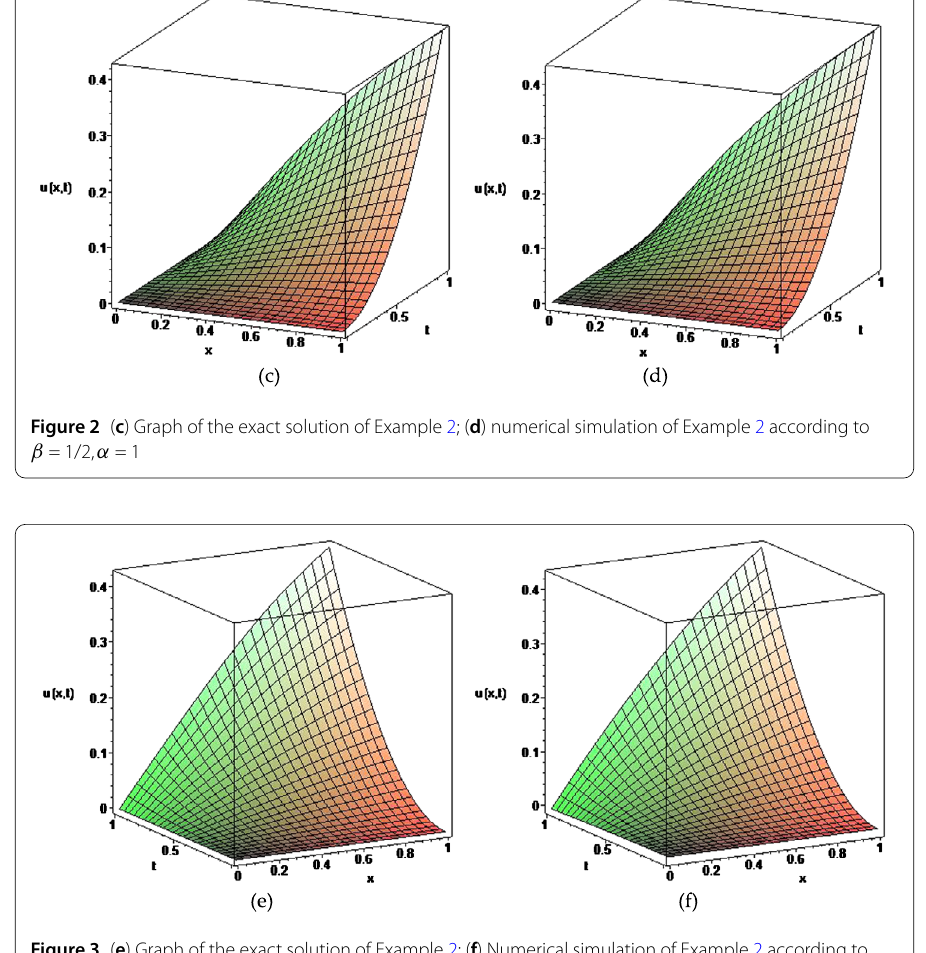
Figure 3 ( e ) Graph of the exact solution of Example 2; ( f ) Numerical simulation of Example 2 according to β = 3/2, α = 1